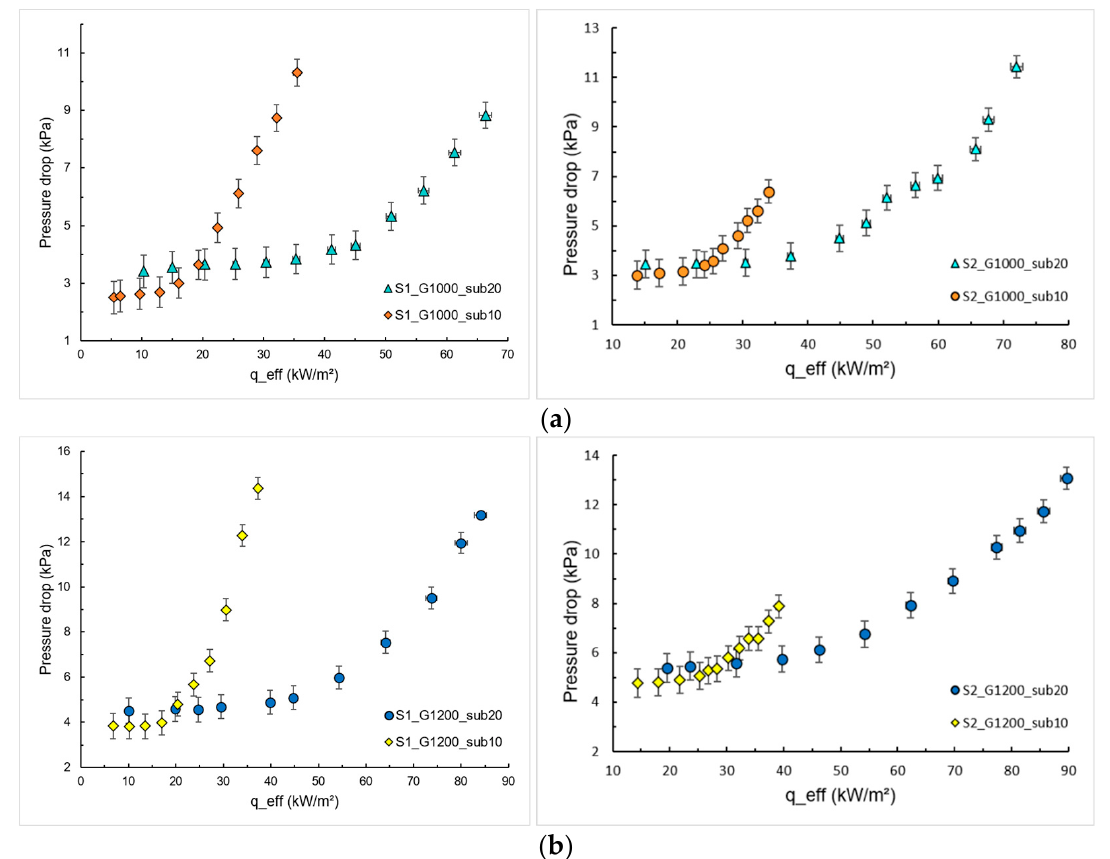
Figure 7. E ff ect of inlet subcooling on the pressure drops for S1 and S2. ( a ) G = 1000 kg/m 2 s; ( b ) G = 1200 kg/m 2 s.